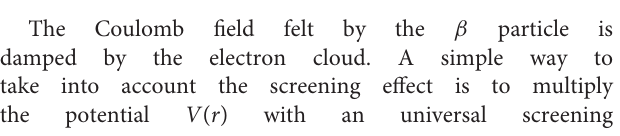
FIGURE 2 | The Coulomb potential V obtained by using the realistic charge density is plotted with a thick full line as function of the radius r . The Coulomb potential obtained with the finite nuclear size approximation is displayed with a thin line. The calculations were performed for the 150